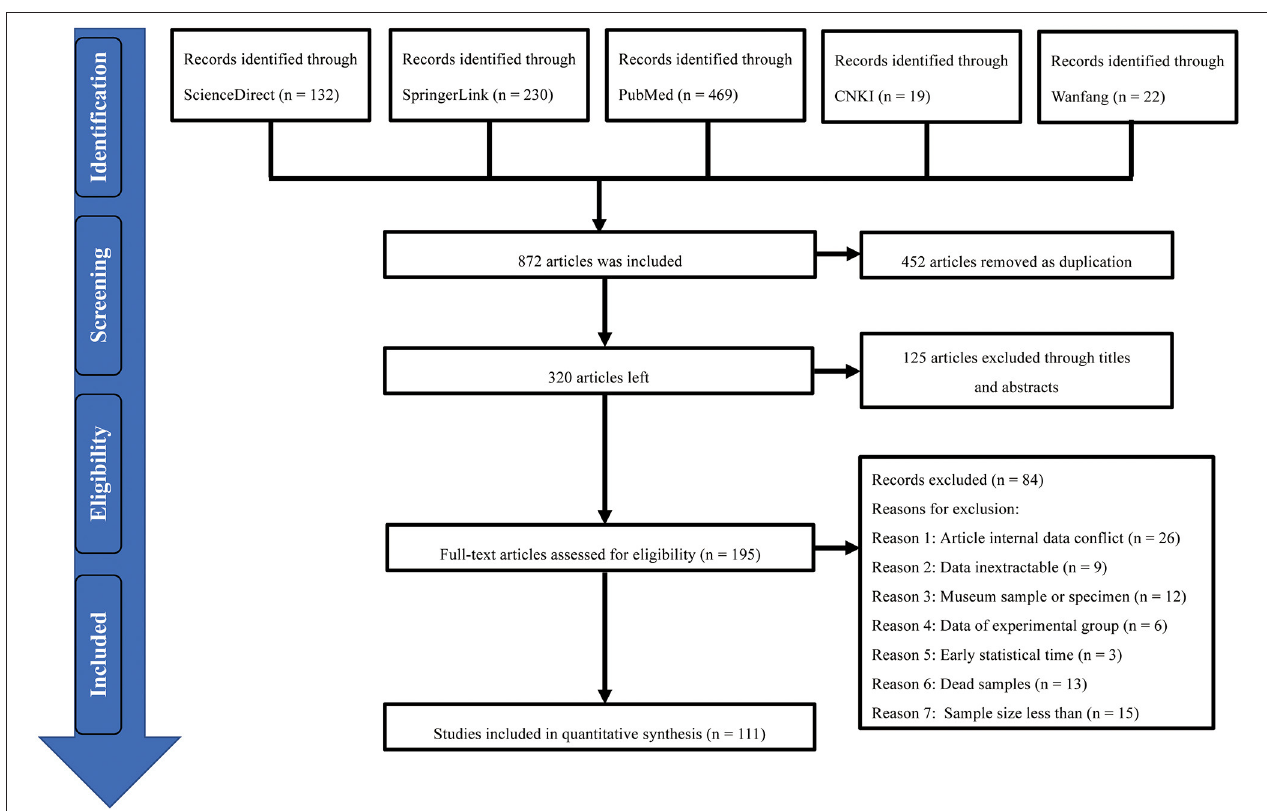
FIGURE 1 | Flow diagram of the study screening process of inclusion and exclusion of studies.